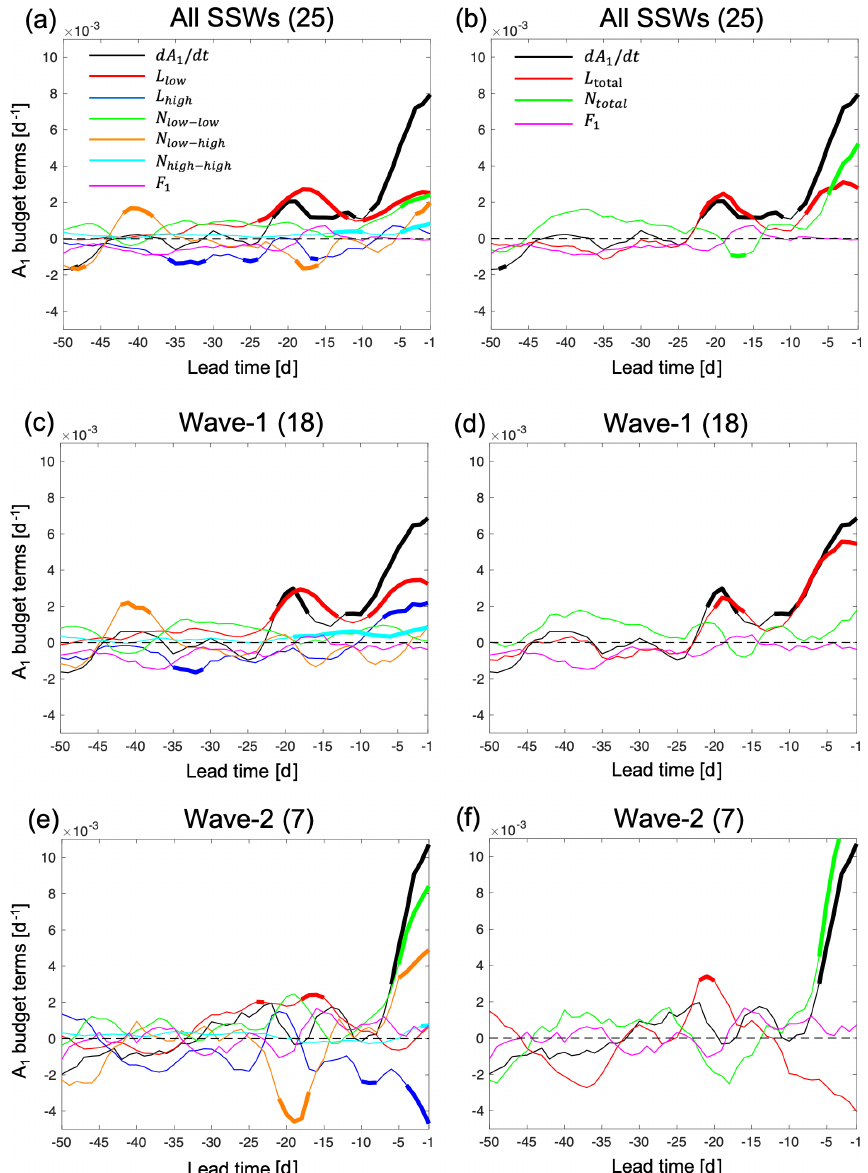
Figure 3. The SSW composite of the A 1 budget as a function of lead time from 50 to 1d before the onset of events in ERA-Interim. (a, b) Composite of all 25 SSW events; (c, d) composite of the 18 wave-1 events; (e, f) composite of the 7 wave-2 events. Panels (a, c, e) show each term of the mode equation budget (Eq. 5) separately, and (b, d, f) show the total linear term and the total nonlinear term for the different subsets of SSWs. The number in the bracket in each panel title indicates the number of SSW events. A 5d running mean is applied to all lines. Bold lines indicate values that are outside the percentile range 2.5 to 97.5 of normal winter day values from bootstrapping as described in the text. The representation of each line color in (c, e) and (d, f) is the same as the legend in (a) and (b) ,